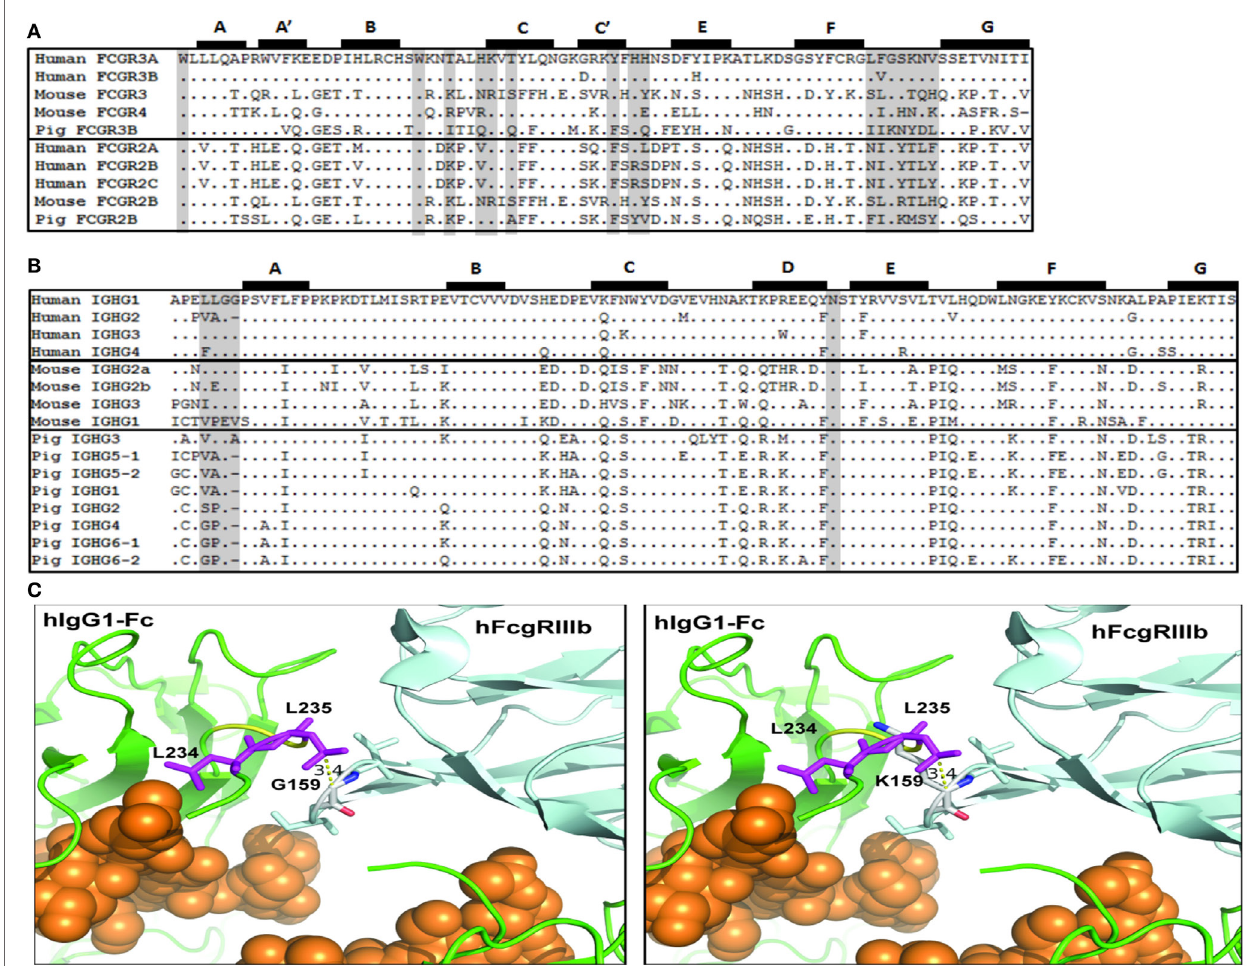
FigUre 7 | Putative amino acid sequence alignment of Fc γ R and IgG subclasses. (a) Second IgG domain of human, mouse, and pig Fc γ receptors. (B) Lower hinge and CH2 domain of human, mouse, and pig IgG subclasses. Previously reported Fc-Fc γ R contact sites are shaded. Beta-strands are labeled and shown at top. (c) Left. Model of the interaction of the Fc region of human IgG1 (green) with human FcgRIIIb (light blue) (pdb, 1t83). Fc-bound glycans are shown as orange spheres. The L234 and L235 Fc residues (purple) and the G159 residue of the Fc γ RIIIb FG loop are identified. Right. Modeling of the positioning of the porcine K159 residue in the FG loop and its clash with the Fc residue